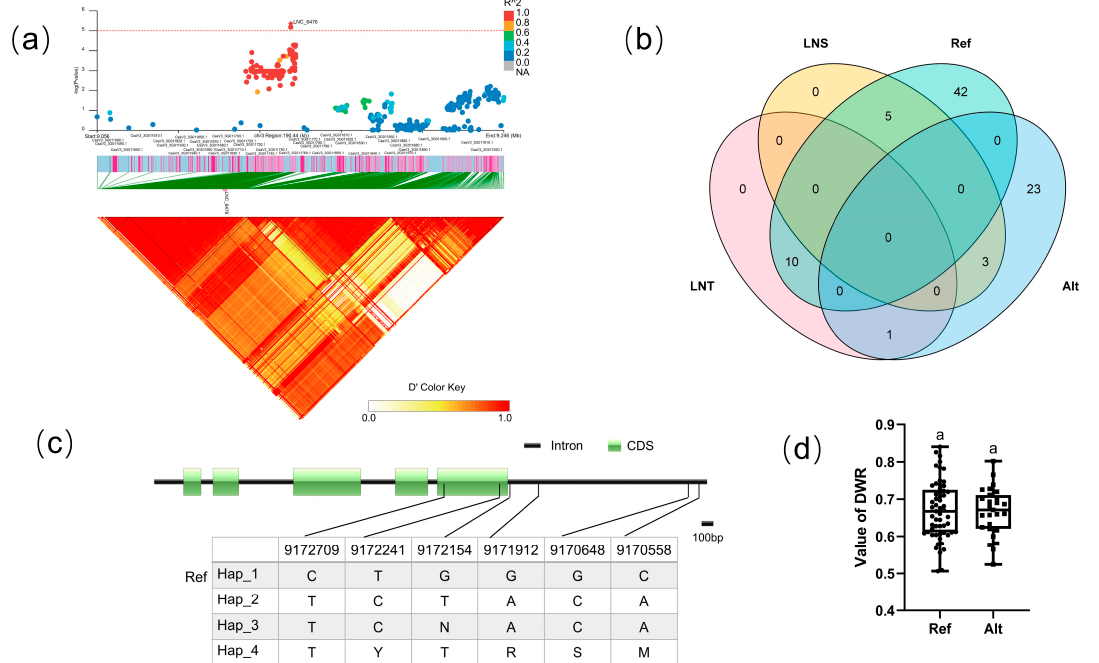
Figure 8. Identification of the low-nitrate tolerance gene at block 2639. ( a ) Manhattan map (top) and LD heatmap (bottom) of the block 2639. ( b ) Raf and Alt of CsaV3_3G011820 in LNS and LNR. ( c ) SNP variation of the candidate gene CsaV3_3G011820 among 4 haplotypes. ( d ) Haplotype difference of CsaV3_3G011820, Different letters meant there was significant difference among groups (p < 0.05).